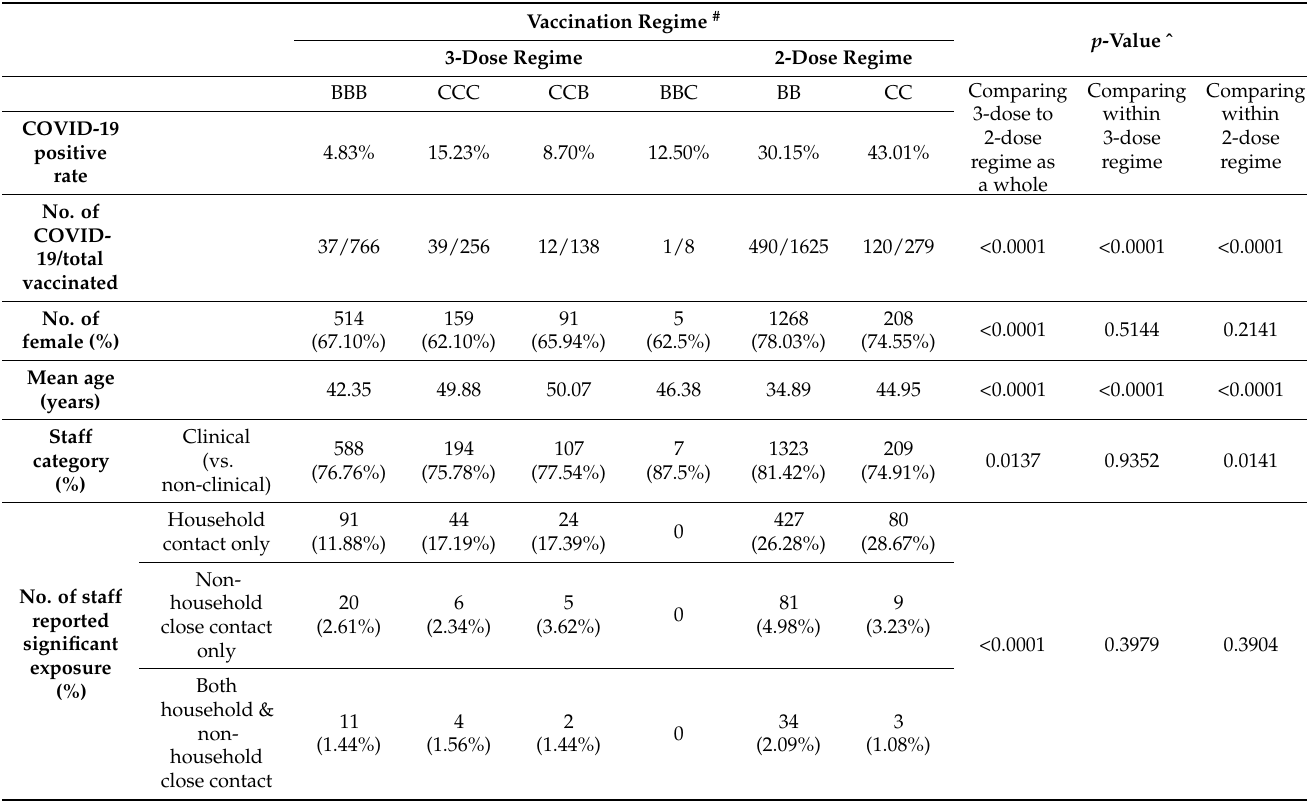
Table 3. Demographics, history of significant exposure and rate of COVID-19 stratified by vaccination